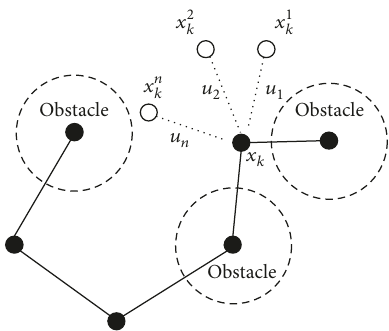
Figure 4: The degree of nodes in a tree.